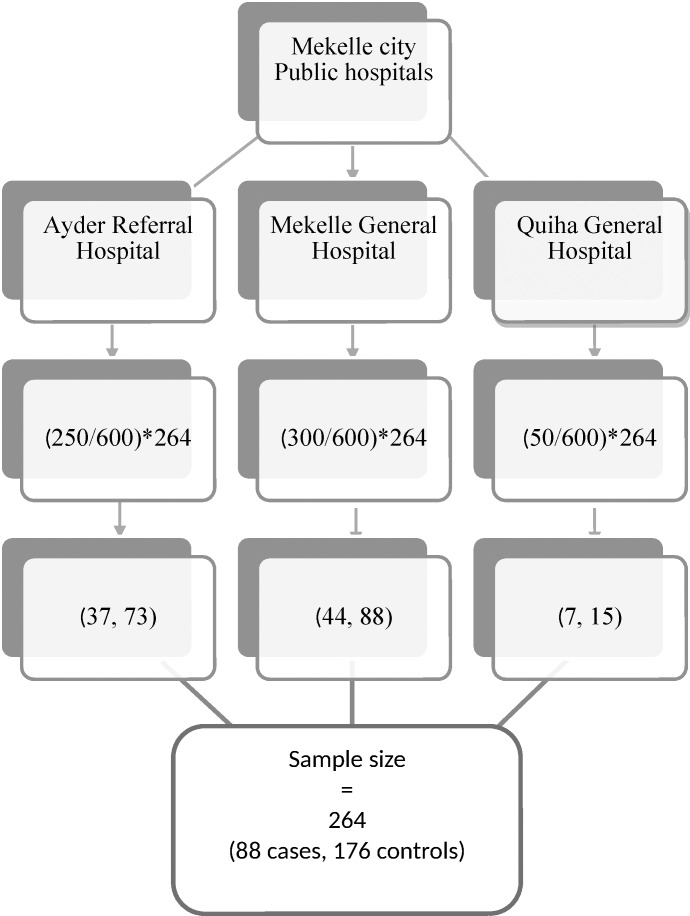
Schematic representation of sampling procedure.↓ = Order of activity. * = Multiplication. / = Division. (250/600)*264 = (monthly flow of laboring mothers/Total number of laboring mothers in the three study hospitals)* total sample size. (37,73) = (number of cases, number of controls allocated to study hospital).